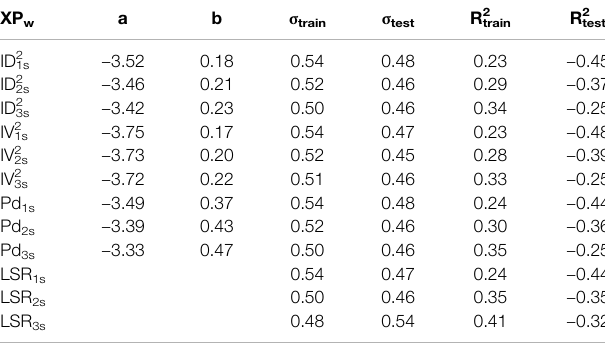
TABLE 8 | Least square regression results, complete